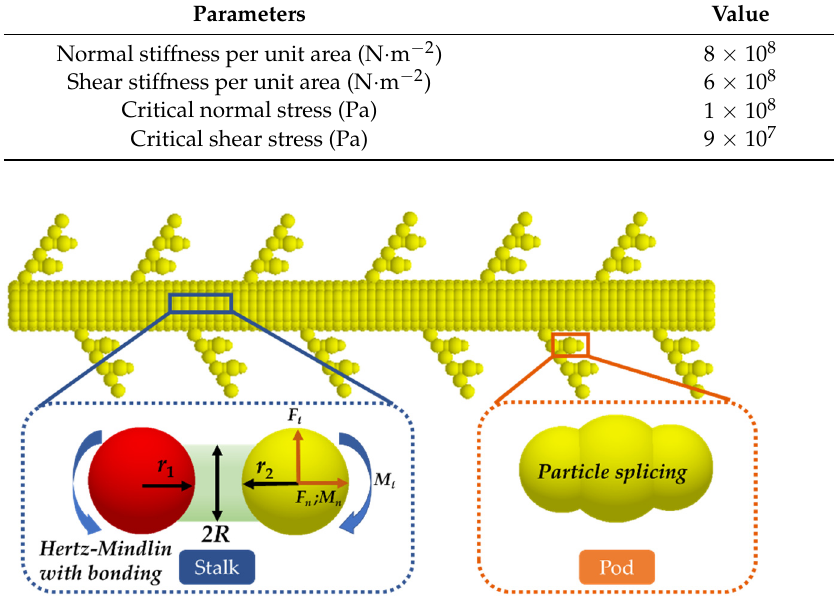
Figure 2. Illustration of the oilseed rape bond. To obtain a simulation model of oilseed rape plants, 100 oilseed rape plants were selected, and the plant length, ear length, and stalk diameter were measured. The biometric parameters of oilseed rape plants are shown in Table